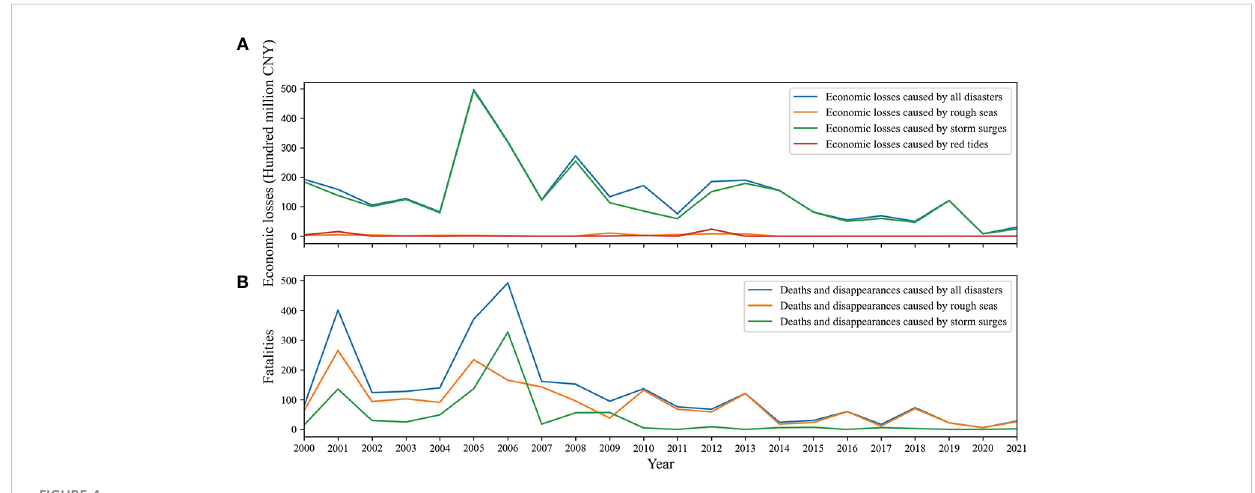
FIGURE 4 (A) Economic loss caused by various disasters. (B) Population losses caused by various